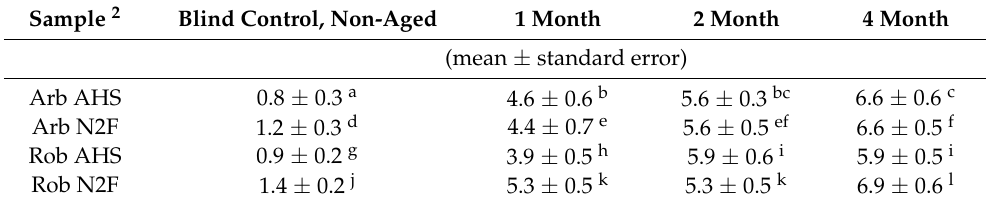
Table 1. Degree of difference (DOD) scores of ready-to-drink (RTD) coffee samples during storage 1 . Sample